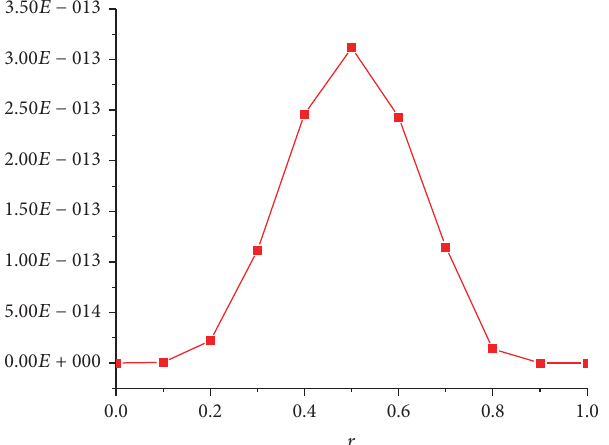
Figure4:Errorgraph(showingconvergenceofOHAM):OHAMup to second-order solution when 𝑈 = 0.2 , 𝛽 1 = 0.1 , 𝛽 2 = 0.3 , 𝜆 = 0.3 , and 𝛿 = 2 .